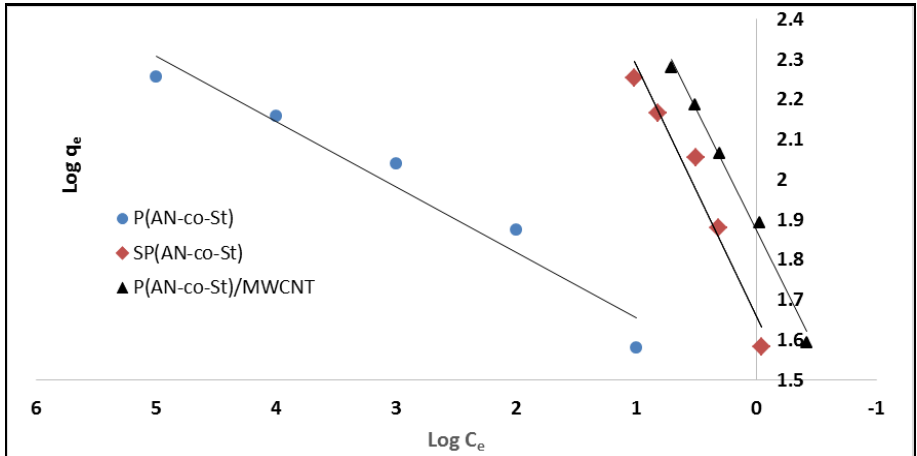
Figure 11. Freundlich plots for adsorption of MO onto different composites.